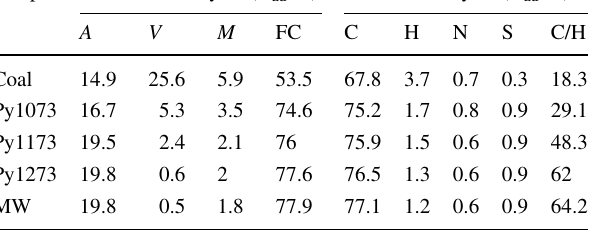
Table 1 Ultimate and proximate analysis of the samples Sample Proximate analysis (w ad